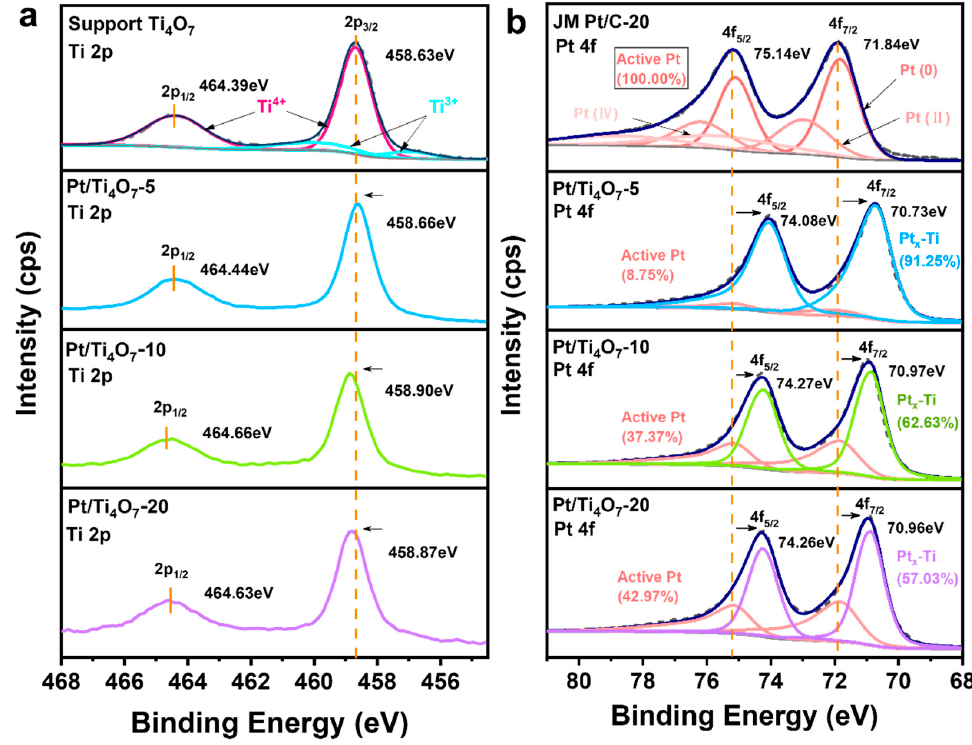
Figure 7. Detailed XPS spectrums of ( a ) Ti 2p for support Ti 4 O 7 , Pt/Ti 4 O 7 -5, Pt/Ti 4 O 7 -10, and Pt/Ti 4 O 7 -20. Detailed XPS spectrums of ( b ) Pt 4f for JM Pt/C-20, Pt/Ti 4 O 7 -5, Pt/Ti 4 O 7 -10, and Pt/Ti 4 O 7 -20.